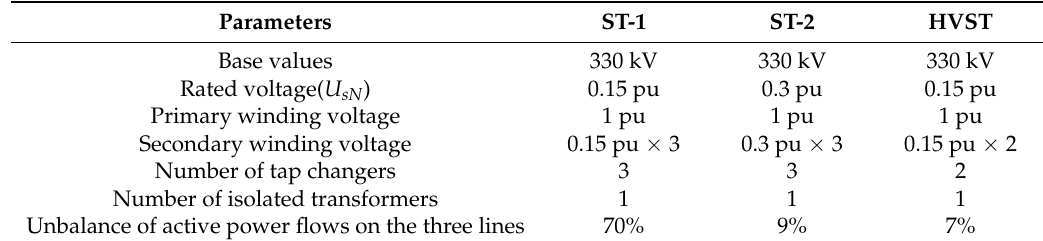
Table 4. Simulation parameters for the ST and the HVST in an IEEE 39 bus system.